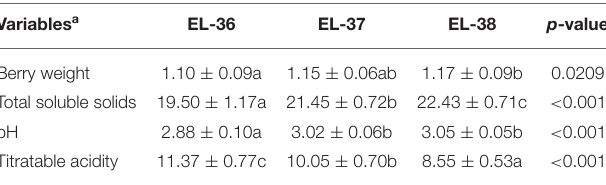
TABLE 2 | Effects of the phenological stage (EL-36, EL-37, and EL-38) on berry weight (g), total soluble solids ( ◦ Brix), pH, and titratable acidity (g L − 1 of